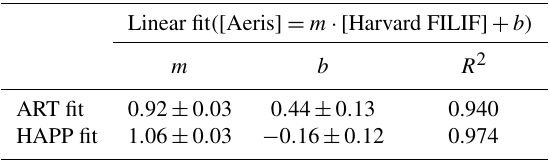
Table 3. Regression analysis for Aeris sensor vs. Harvard FILIF sampling ambient air calculated with a 95% confidence